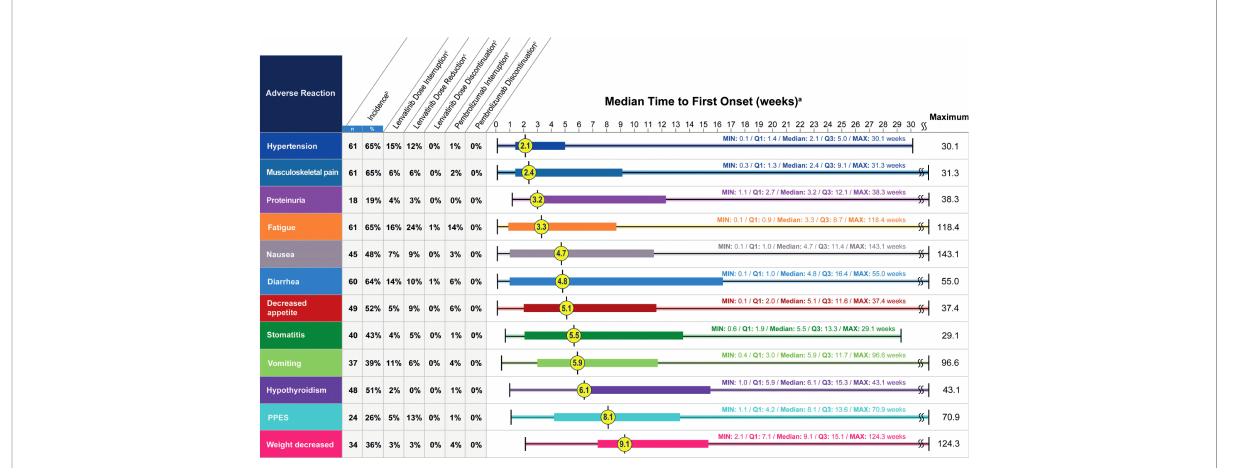
FIGURE 1 Post hoc analysis of time to fi rst onset of selected adverse reactions. Reproduced with permission from